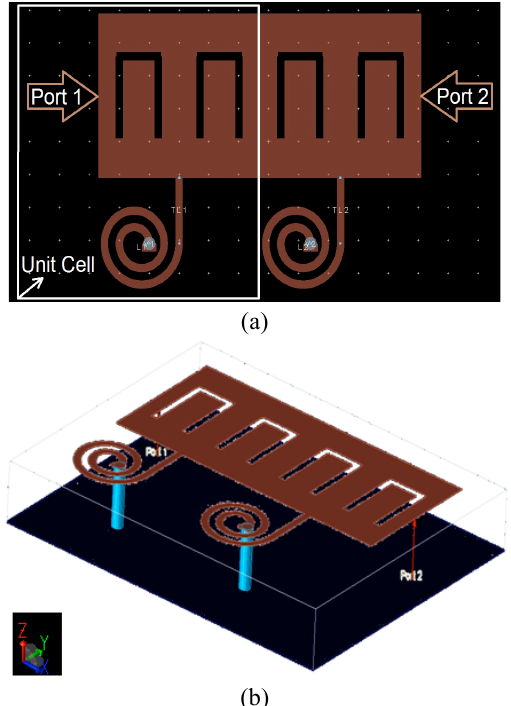
Figure.1. Configuration of the presented UWB miniature antenna combined of two unit cells based on CRLH MTM- TL. a) Top view, b) Isometric view.